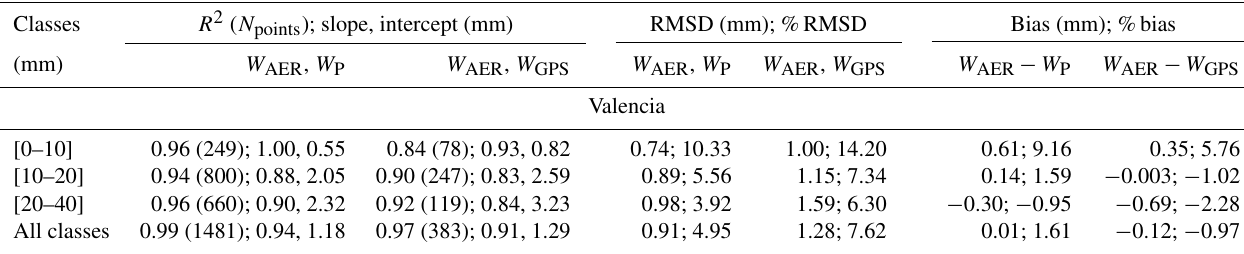
Table 4. Parameters of the statistical analysis in the comparison against W AER of W P and W GPS estimations for Valencia site: squared correlation coefficient, slope and intercept of the fitting lines, RMSD and